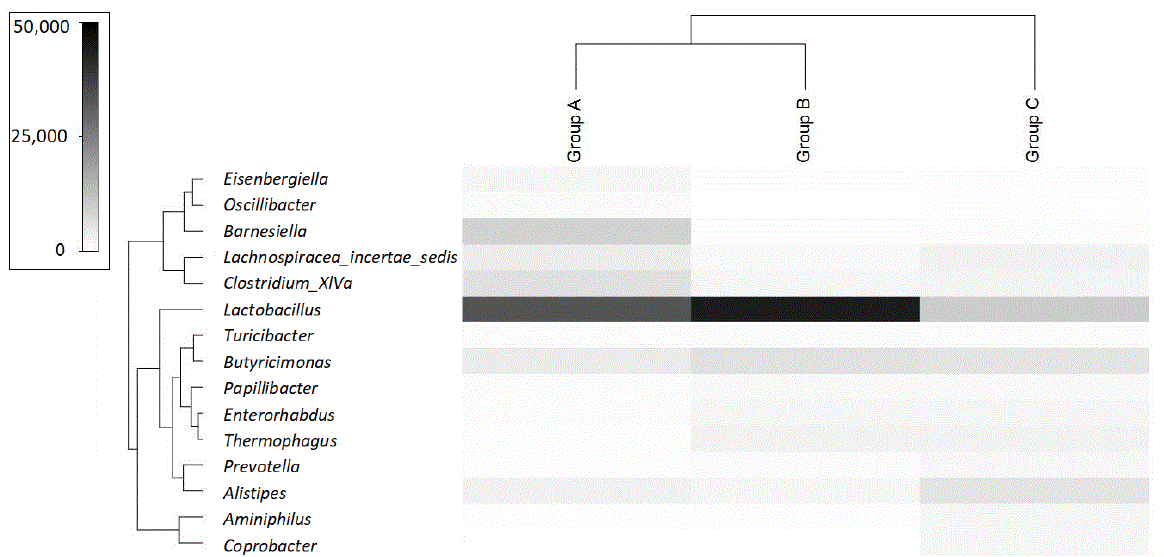
Figure 4. Hierarchical clustering dendrogram on 16S amplicon sequencing data. Dendrogram shows hierarchical clustering of samples based on genus-level classifications. The bar chart under each sample summarizes the relative abundance of its genus-level classifications, as measured in number of reads. Samples are divided based on the different levels of S100B (A = lower than 1.75 ng/mL, B = between 1.76 and 2.4 ng/mL, C = higher than 2.5 ng/mL).